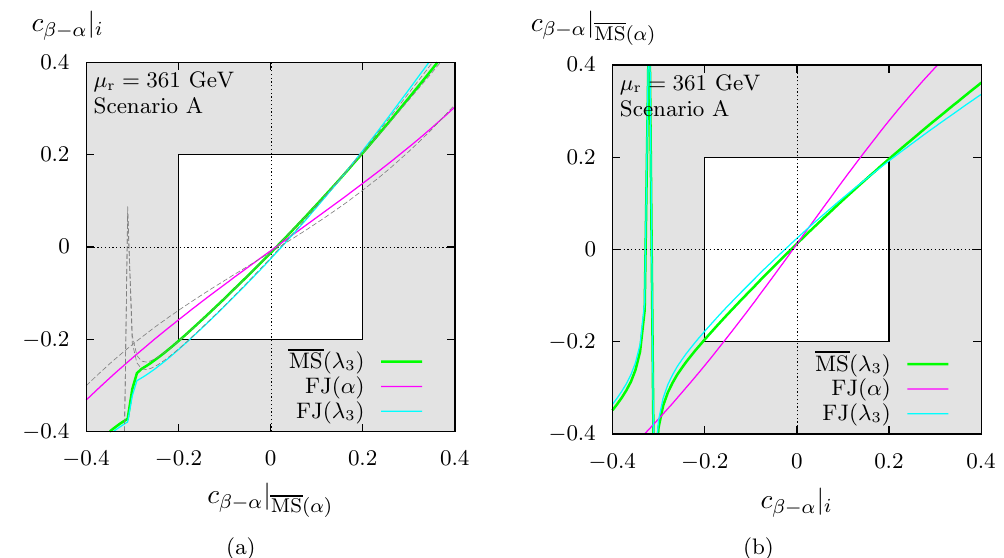
Figure 8 . Panel (a): conversion of the value of c (cid:12) (cid:0) (cid:11) from MS( (cid:11) ) to the MS( (cid:21) (pink), and FJ( (cid:21) 3 ) schemes (turquoise) for scenario A. Panel (b) shows the conversion to the MS( (cid:11) ) scheme using the same colour coding. The solid lines are obtained by solving the implicit equations numerically, the dashed lines correspond to the linearized approximation. The phenomenologically relevant region is highlighted in the